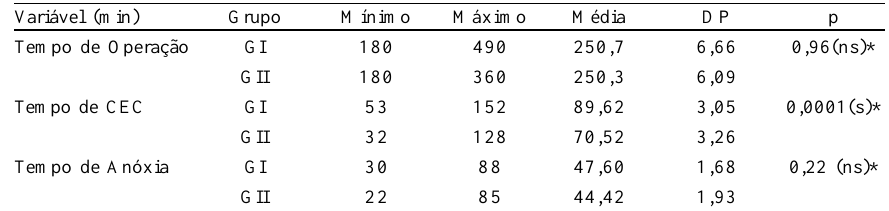
Tabela 5. Tempos